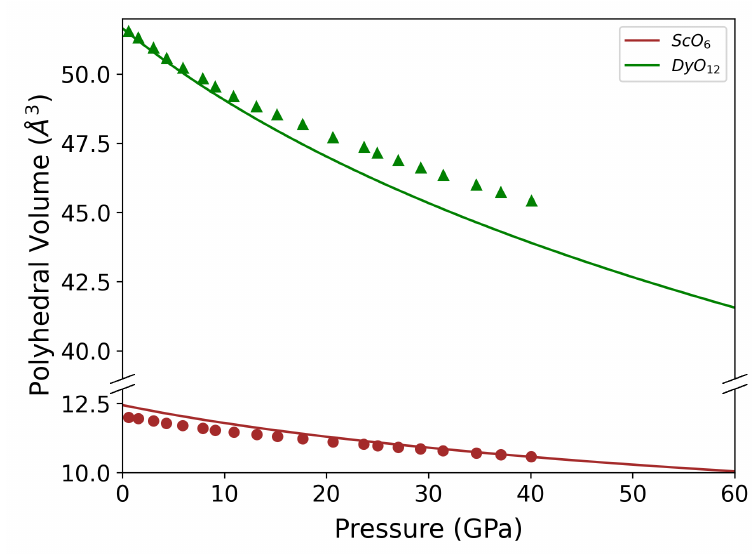
Figure 5. Variation of the polyhedral volumes of DyScO 3 perovskite with pressure. Solid curves represent the calculated values and symbols represent the experimental values from Ref. [11].